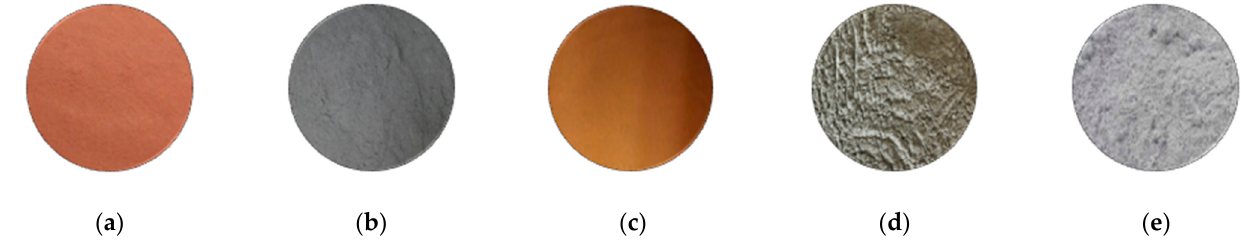
Figure 1. Test materials. ( a ) Red mud, ( b ) loess, ( c ) ordinary Portland cement, ( d ) fly ash, and ( e ) carbide slag.